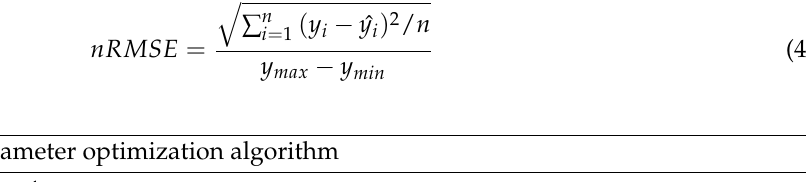
Algorithm 1: Model parameter optimization algorithm Data: Calibration